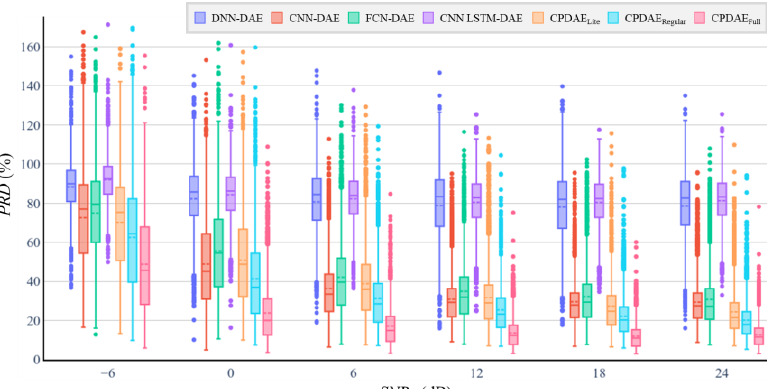
Figure 14. Box plots for SNR imp comparison of the denoising criteria of all of the evaluated methods under six SNR in for the testing phase of NSRDB with EM noise; the box plots include outliers (dot), minimum, interquartile range, median, maximum, and average (dotted line).